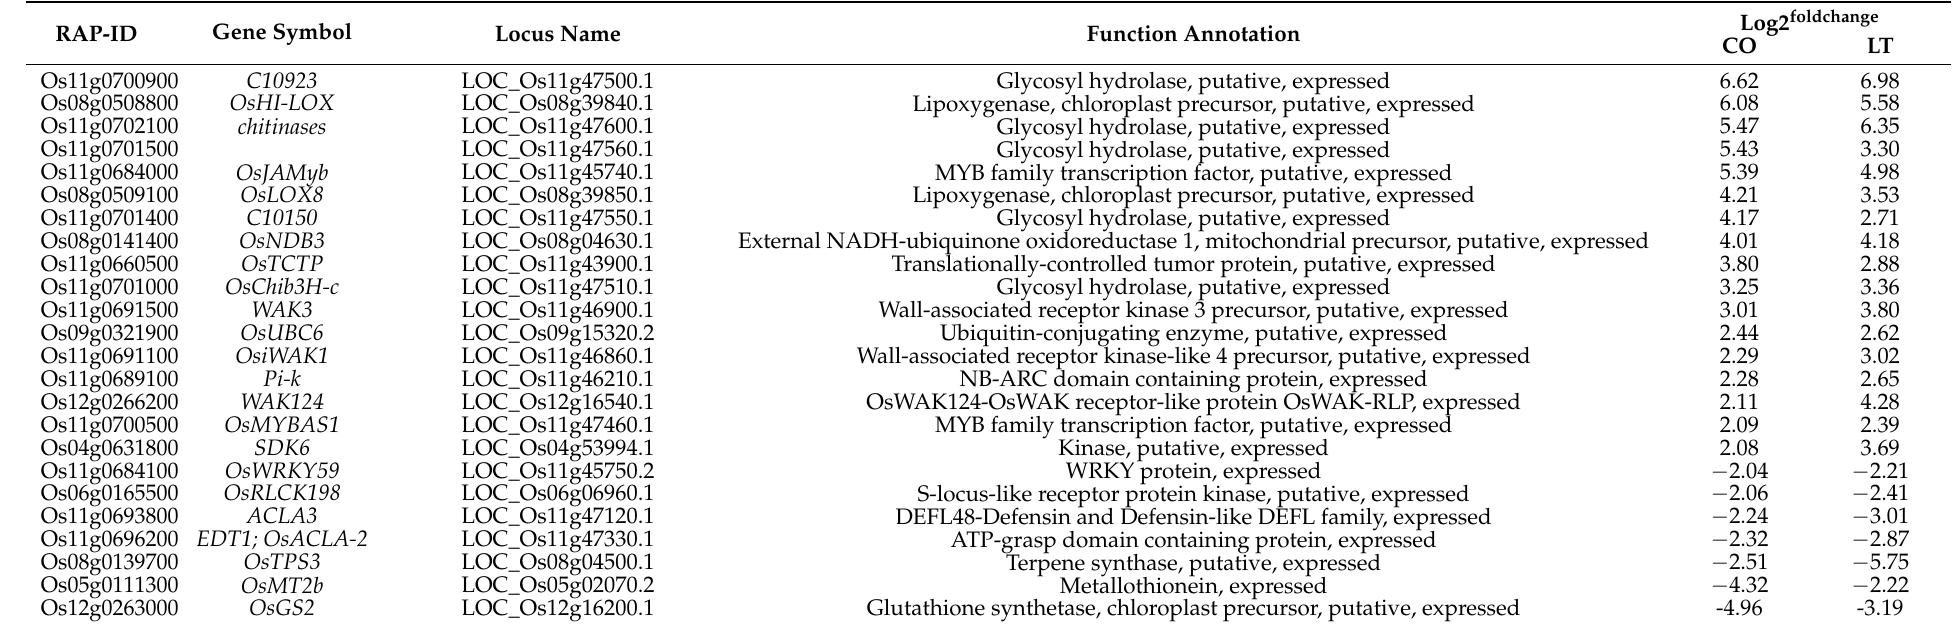
Table 3. 24 significant candidate genes in the top 5 enrichment GO